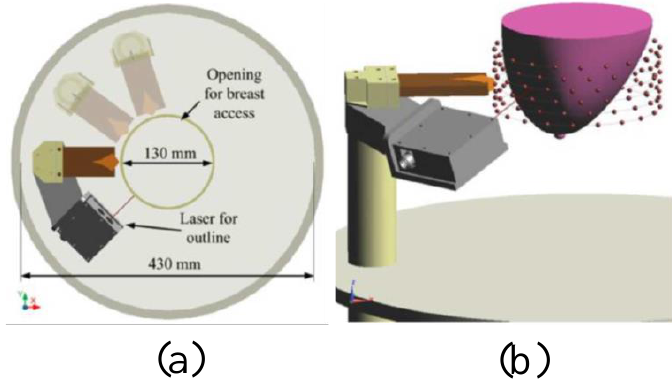
Figure 19. View of the radar-based MI system for breast cancer detection developed by Fear et al. [78]. ( a ) Top-down view of the antennas and laser setup. ( b ) Showing the breast holder consisting of a tank, laser, and antennas. Reprinted with permission from